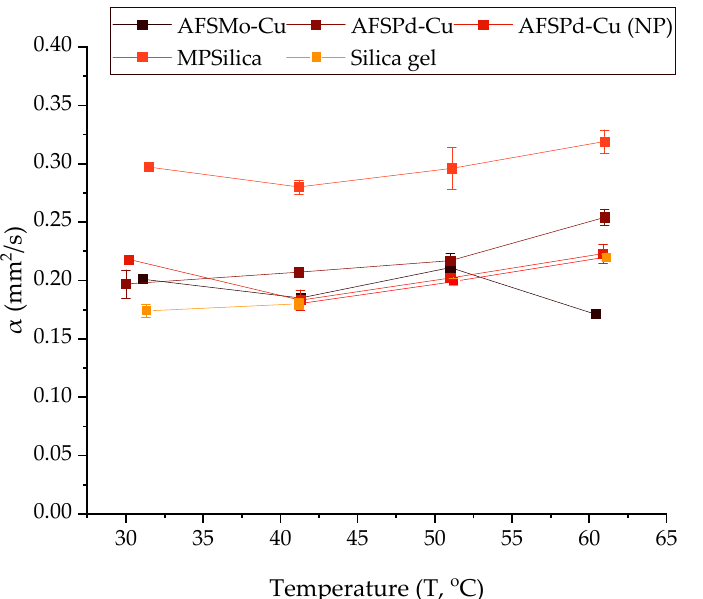
Figure 5. Thermal diffusivity coefficient of selected samples measured at four process temperatures (30, 40, 50, 60 ◦